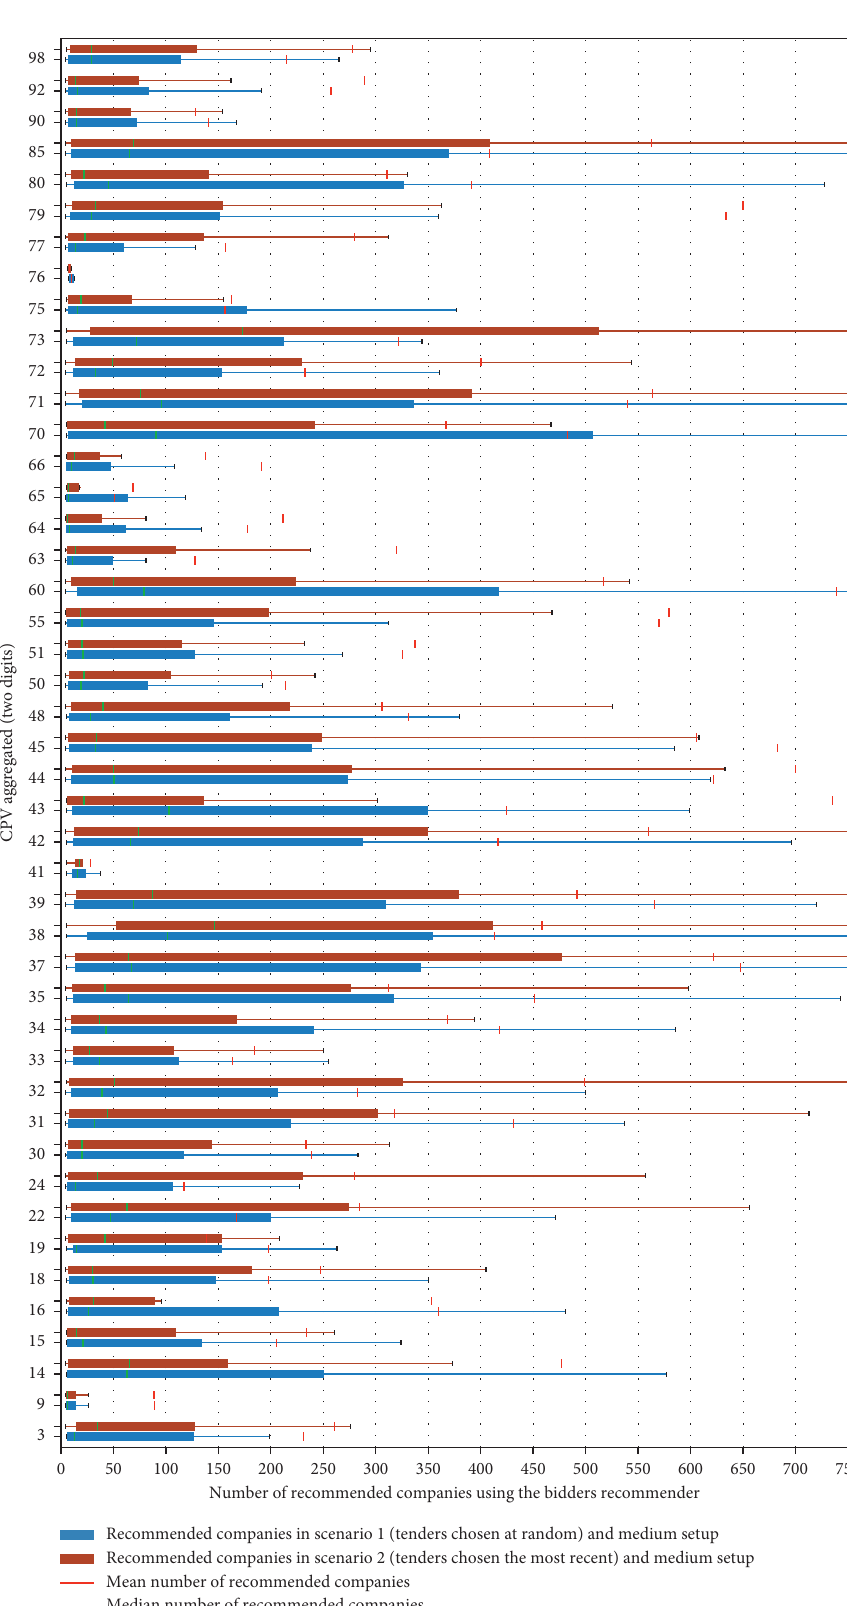
Figure 7: Boxplots for the size of the recommended companies group generated by the bidders recommender, disaggregated by CPV. Scenario 1 (blue colour) and scenario 2 (brown colour) both have a medium